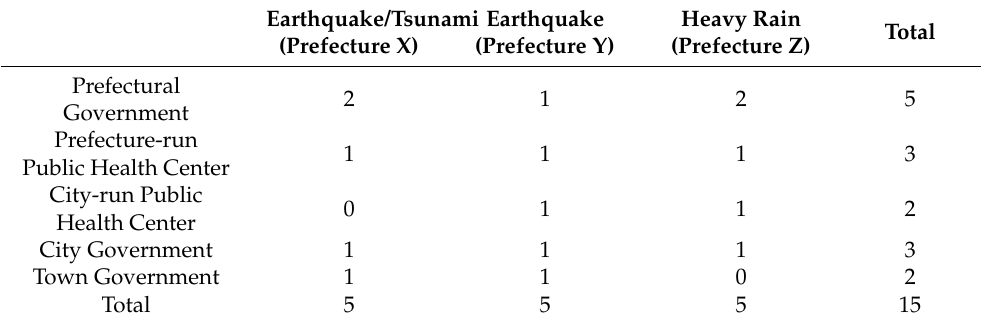
Table 2. Number and categorization of local government dietitians who participated in group